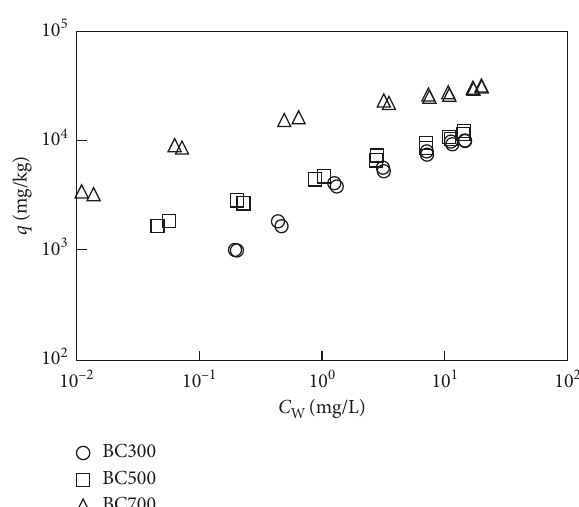
Figure 5: Adsorption isotherms of BPA to BC300, BC500, and